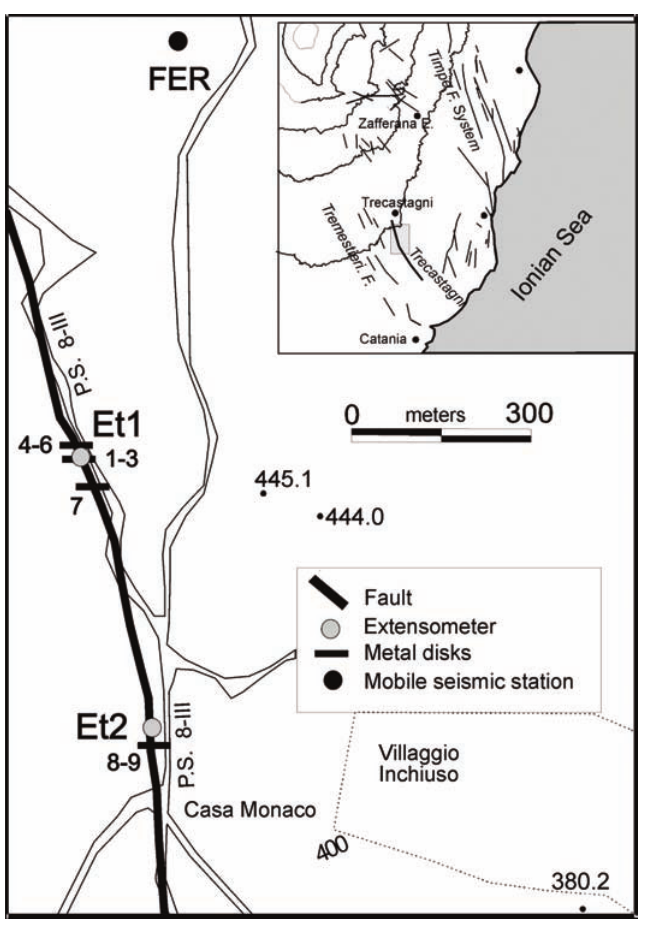
Figure 2. Location map of the extensometer stations Et1 and Et2, the discrete measurement sites, and the FER mobile seismic